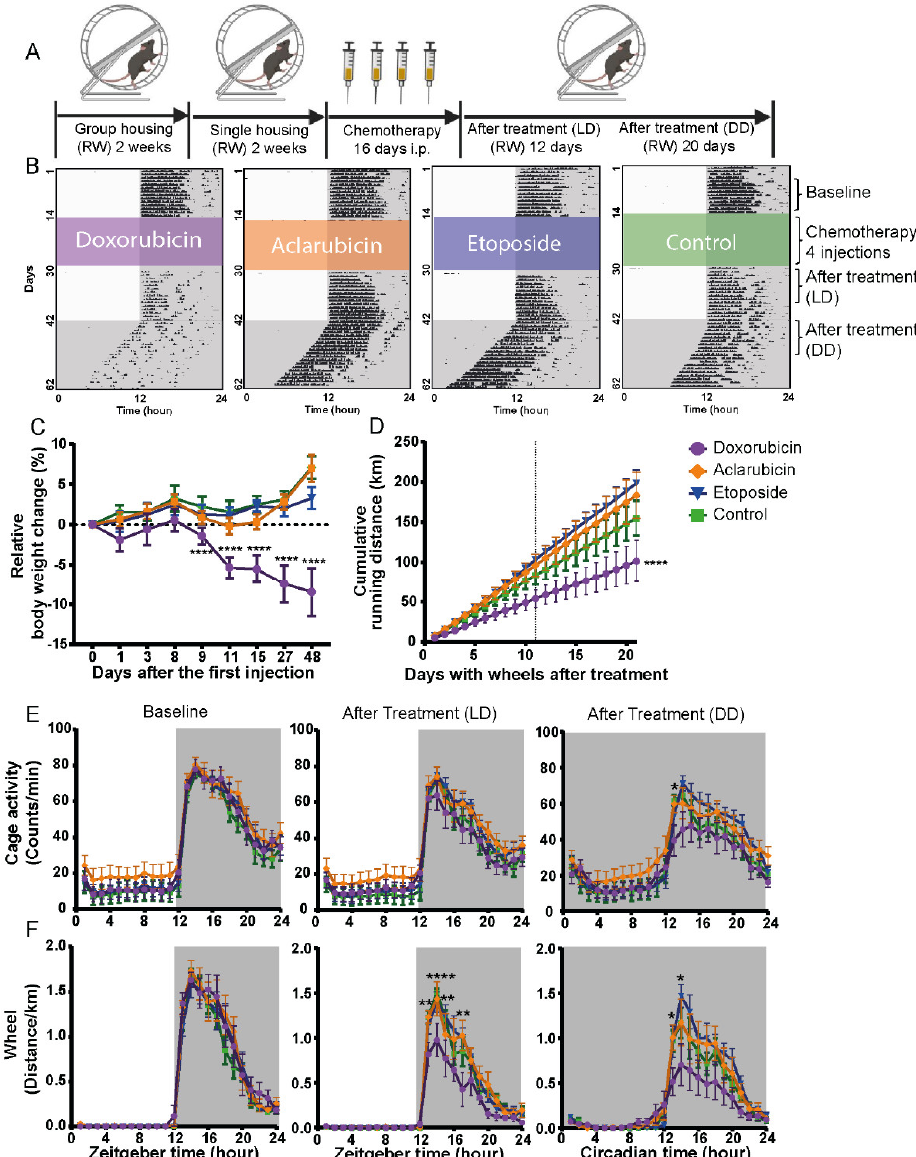
Figure 1. Doxorubicin treatment affects wheel-running activity under light-dark and constant dark conditions. ( A ) Experimental design of the rest-activity behavior study. RW—running wheel; LD—light-dark; DD—constant dark. ( B ) Representative single plotted actograms of wheel-running activity under different chemotherapy treatments during the whole experiment. Black areas indicate wheel activity. Colored areas indicate the treatment time with different cytostatic drugs. ( C ) Relative body weight changes after chemotherapy of the four groups (**** p < 0.0001 two-way ANOVA with Bonferroni multiple comparisons, doxorubicin n = 8, all other treatments n = 9 per group). ( D ) Cumulative running distance during the DD phase (active phase) across 21 days, starting 7 days after the last injection. Vertical line indicated the mice were under DD condition (**** p < 0.0001, Mann–Whitney U test). ( E ) Average cage activity PIR counts/min over 10 days under baseline condition (left), treatment LD condition (middle), and treatment DD condition (right). ( F ) Average running distance/h over 10 days under baseline condition (left), treatment LD condition (middle), and treatment DD condition (right) (* p < 0.05, ** p < 0.01, **** p < 0.0001 doxorubicin compared to control group, two-way ANOVA with Bonferroni multiple comparisons). Values are shown as mean/hour ± SEM. N = 8–9. Grey areas in B, E, and F indicate the dark